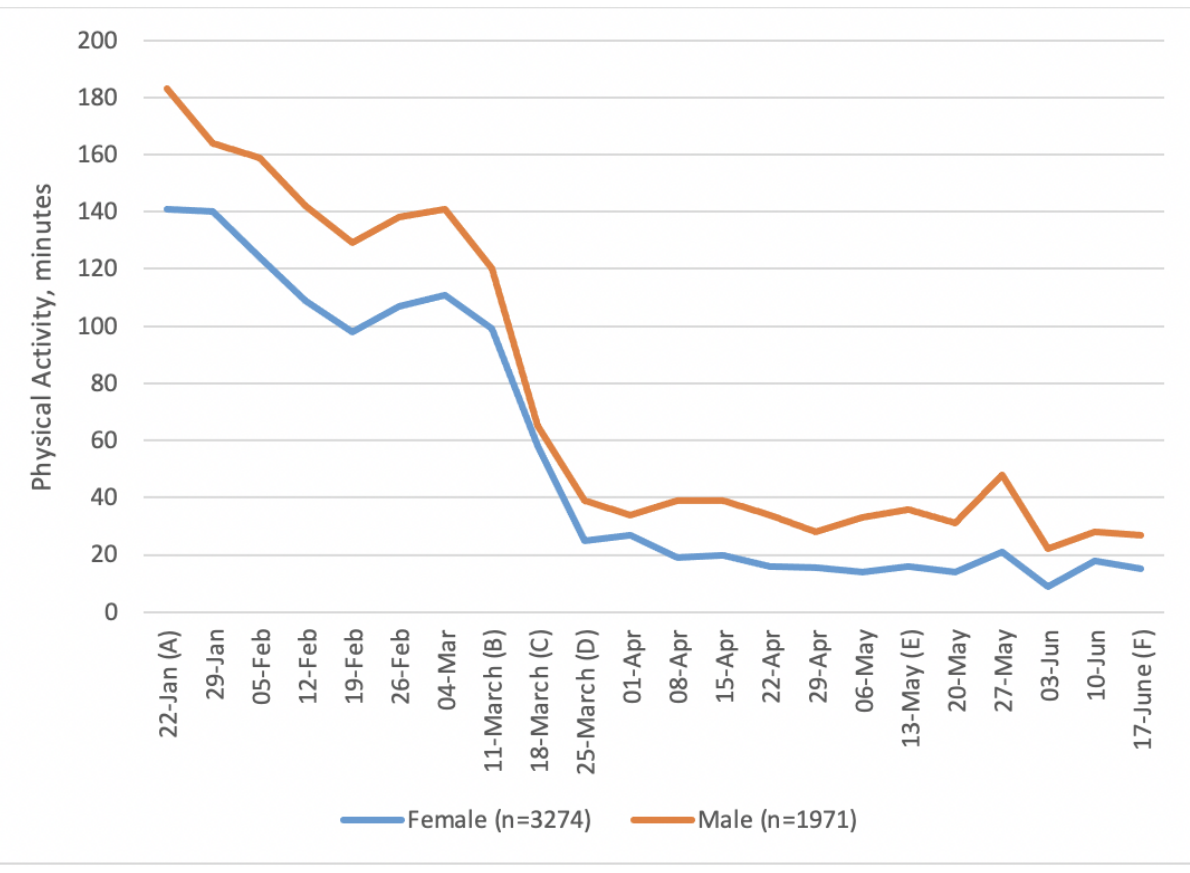
Figure 2. Weekly minutes (median) of activity in males and females (the "other" group was too small). Important dates are marked on the x-axis as follows. (A) January 22: Baseline, week before first COVID-19 case announced in the United Kingdom. (B) March 11: Social distancing measures introduced. (C) March 18: Lockdown begins. (D) March 25: First full week of lockdown. (E) May 13: Lockdown measures relaxed. (F) June 17: Shops